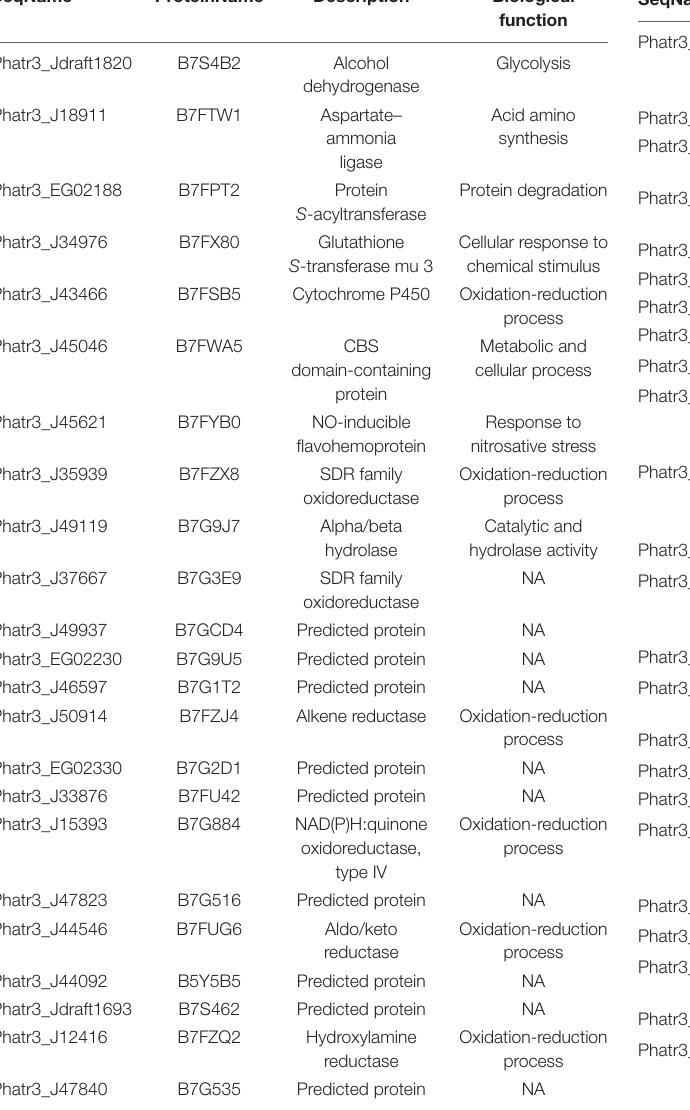
TABLE 2 | Biological process in which oval morphotype up-regulated proteins are involved. SeqName ProteinName Description